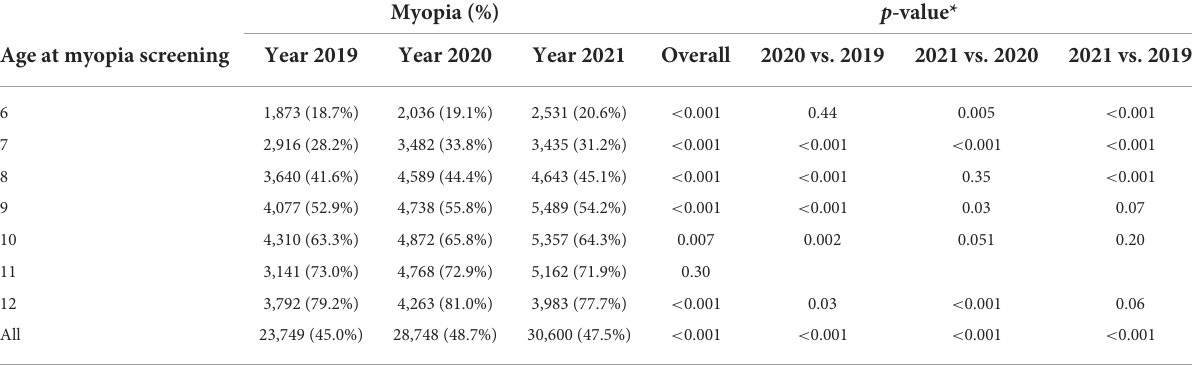
TABLE 2 Comparison of spherical equivalent across 3 years overall and stratified by age at myopia screening. Mean (SD) P –value* Age at myopia